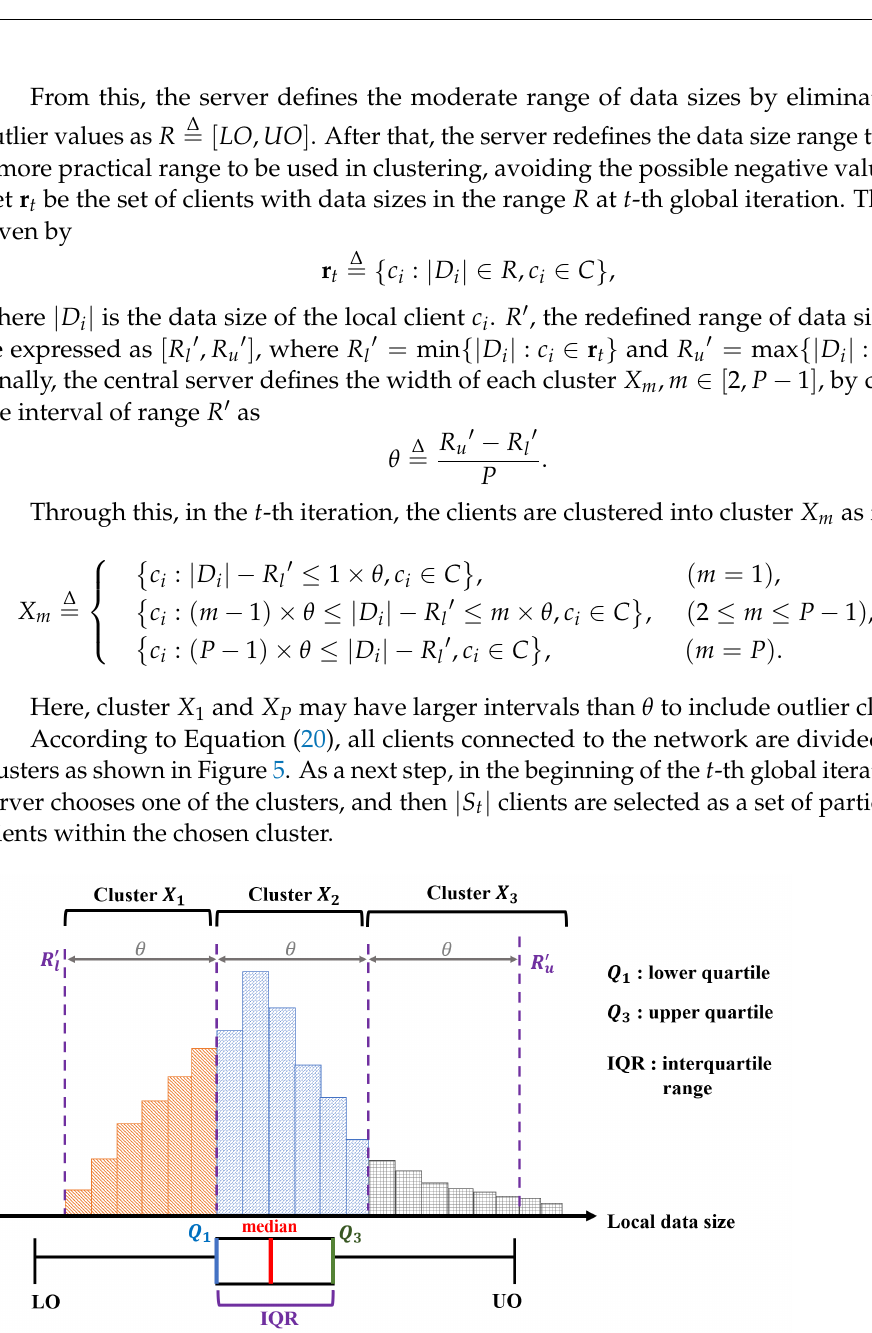
Figure 5. Example of the clients clustering when P =